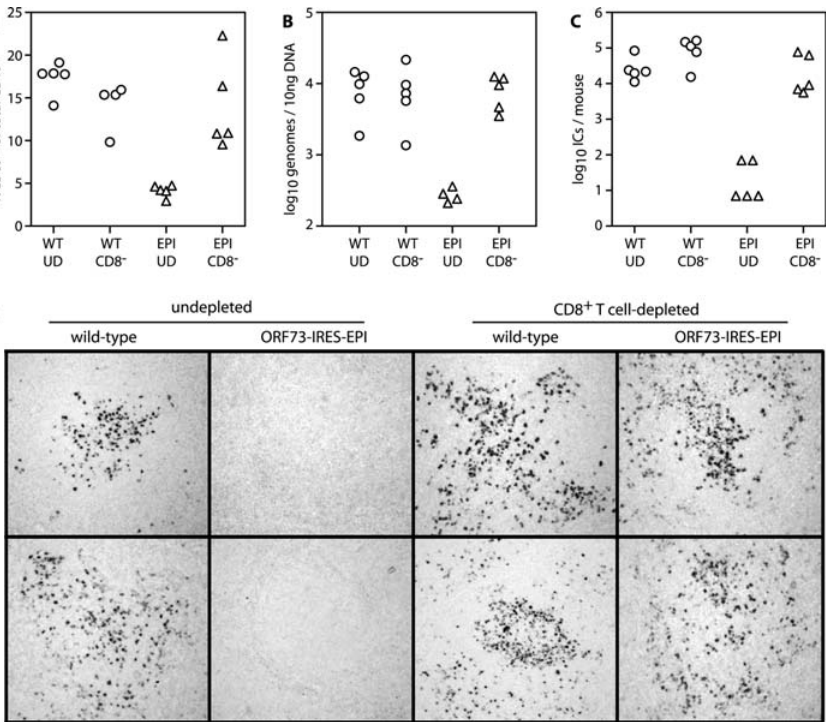
Figure 7. Rescue of the EPI Virus by CD8 þ T Cell Depletion Mice were left undepleted (UD) or depleted of CD8 þ T cells (CD8 (cid:1) ) by an initial intravenous injection of mAb YTS169 2 d before infection, followed by intraperitoneal injections of the same antibody every 2–3 d up to the time of sampling. Infection was by intranasal inoculation of either WT or EPI viruses. (A) Depletion was 95%–99% complete as assessed by flow cytometry of spleen cells. CD69 expression on splenic B cells was measured 13 d post- infection. (B) Genome loads were measured 13 d post-infection by real-time PCR. Each point shows an individual mouse. (C) The infectious centre titres of individual mice at 13 d post-infection are shown for one of two equivalent experiments. The titres of pre- formed, infectious virus in freeze-thawed spleens were less than 5% of the infectious centre titres, so even after CD8 þ T cell depletion, the infectious centre assay essentially measured latent virus. By 13 d post-infection, the lungs of both immunocompetent and CD8 þ T cell–depleted mice were clear of infectious virus. (D) In situ hybridization for viral tRNA expression in splenic germinal centres is shown 13 d after infection of CD8 þ T cell–depleted or undepleted mice, infected with either EPI or WT virus. Spleens of two representative mice are shown in each case. DOI: 10.1371/journal.pbio.0030120.g007